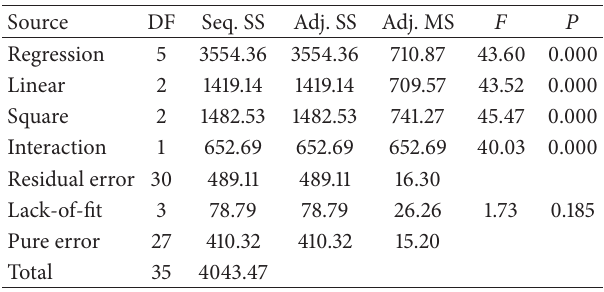
Table 6: Analysis of variance for tensile strength.